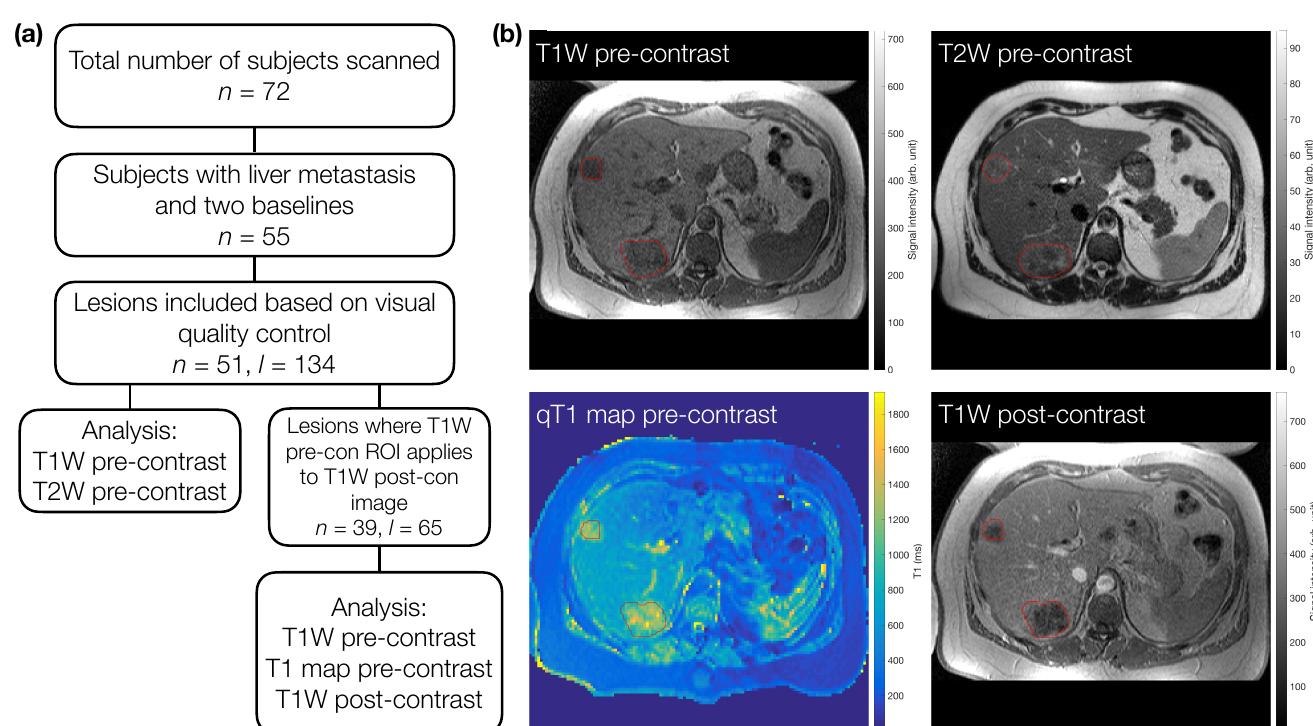
Figure 1. ( a ) Flowchart for subject and lesion selection. For T 1 W and T 2 W pre-contrast images, a total of 51 subjects ( n ) with 134 lesions ( l ) were included. Sixty-five of these lesions were also analysed on T 1 W post-contrast images and pre-contrast Figure 1. (a) Flowchart for subject and lesion selection. For T1W and T2W pre-contrast images, a total of 51 quantitative T 1 maps. For direct comparison in terms of number of lesions included, the T 1 W pre-contrast images from this subjects ( n ) with 134 lesions ( l ) were included. Sixty five of these lesions were also analysed on T1W post-contrast subset were re-analysed in 39 patients. ( b ) Example images for one subject with two metastases (red images and pre-contrast quantitative T1 maps. For direct comparison in terms of number of lesions included, the T1W pre-contrast images from this subset were re-analysed. (b) Example images for one subject with two metastases (red outlines).